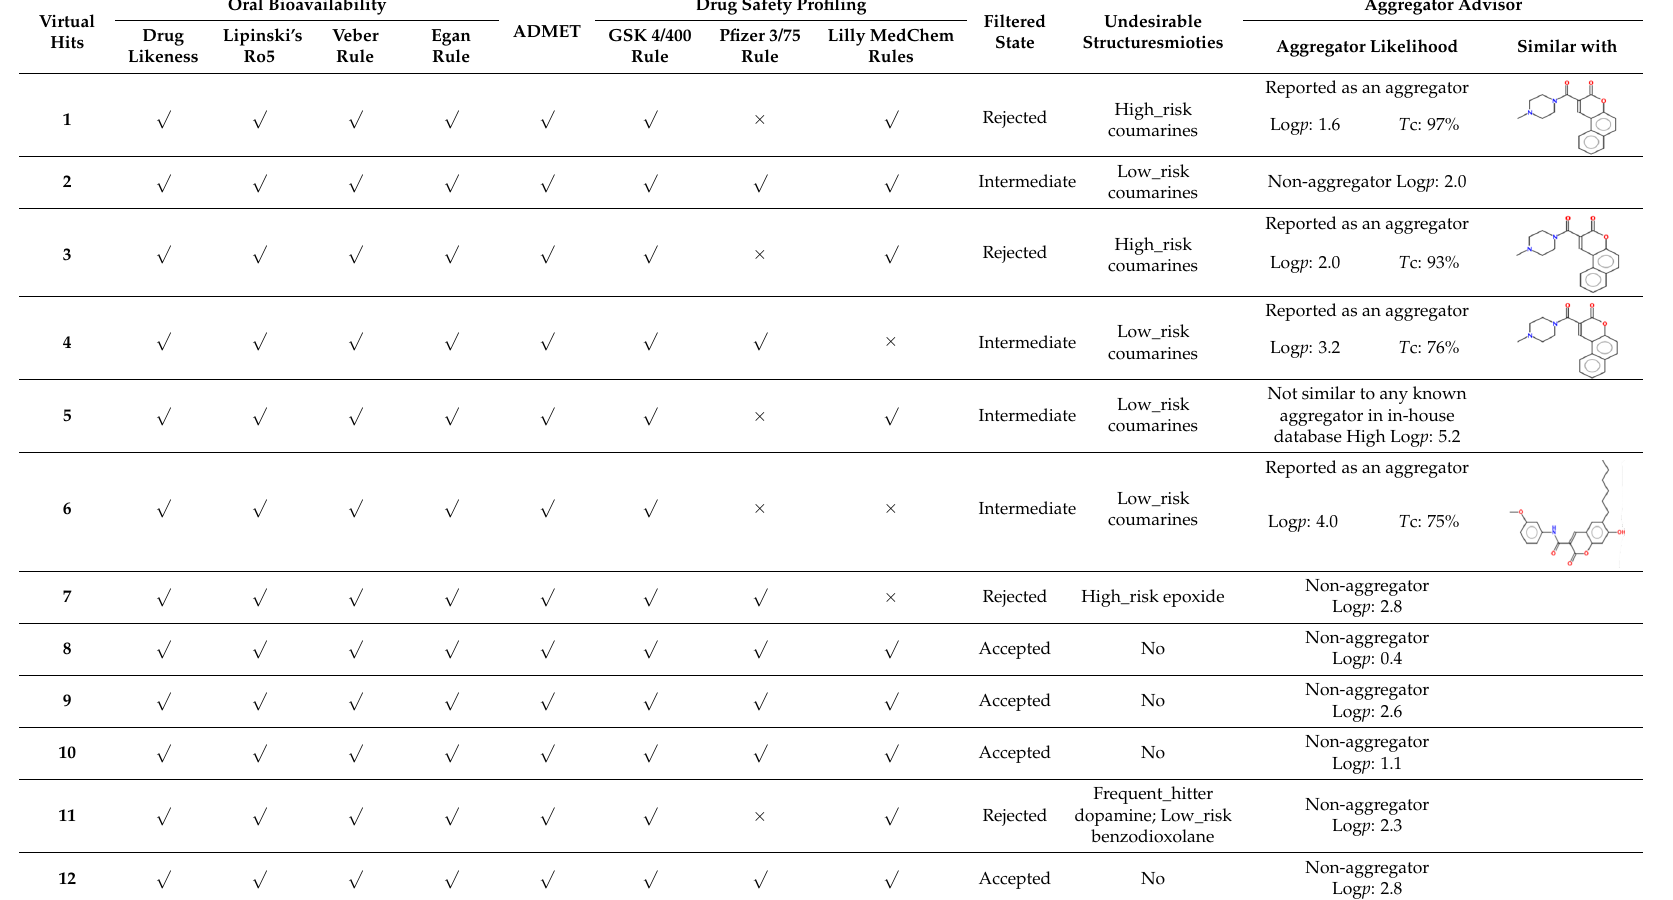
Table 2. Screening of 13 virtual hits from series of filters being